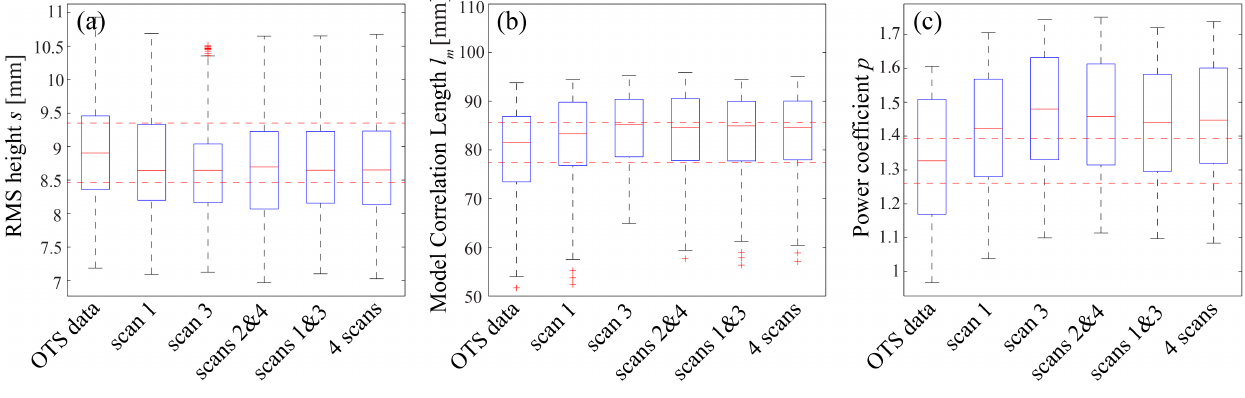
Figure 10. The values of ( a ) root mean square height, ( b ) model correlation length and ( c ) power coefficient, estimated from the rows of the six optimal DEMs and presented as